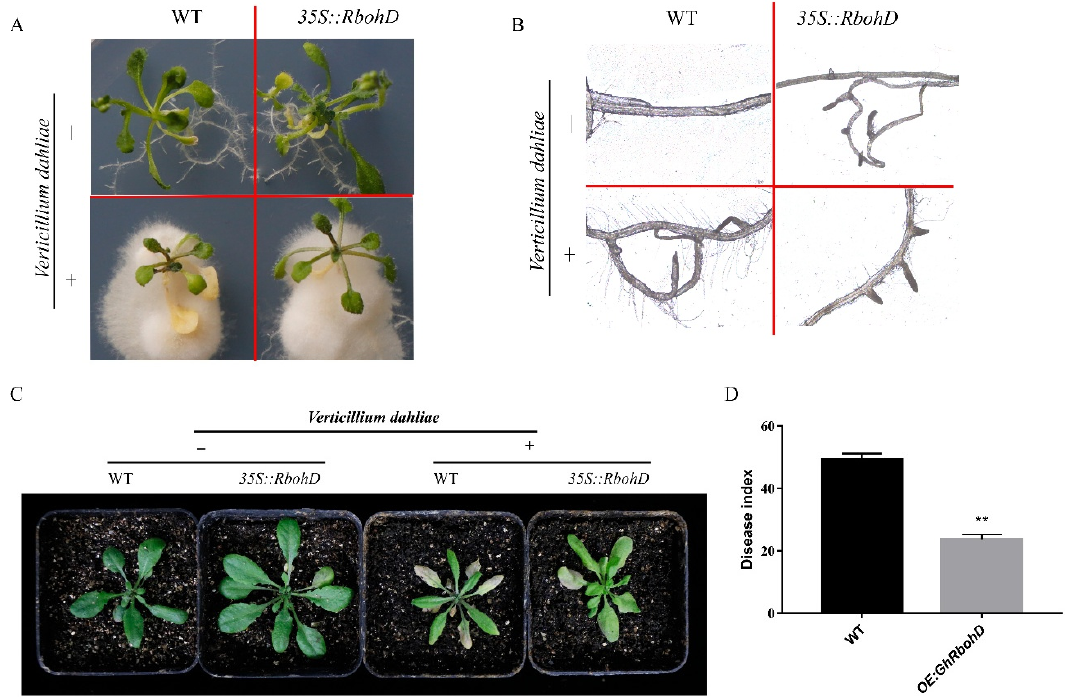
Figure 6. Overexpressing GhRbohD Arabidopsis thaliana enhanced the resistance to V. dahliae . ( A ) Disease resistance phenotypes of WT and OE-GhRbohD Arabidopsis inoculated with V. dahliae in MS culture medium. ( B ) The amount of mycelium attachment around the roots. ( C ) Disease resistance phenotypes of WT and OE-GhRbohD Arabidopsis inoculated with V. dahliae . ( D ) The DI of WT and OE-GhRbohD Arabidopsis . Asterisks indicate statistically significant differences, as determined by Student’s t -test (** p < 0.01).